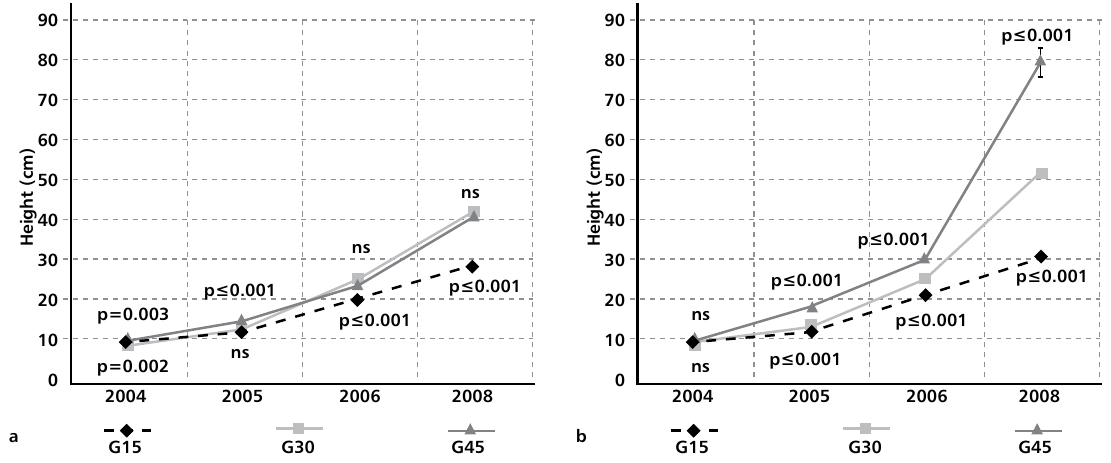
Figure 2 Height of sessile oak (a) and hornbeam (b) seedlings before (2004) and after cutting gaps of various sizes. Medium-size gaps were compared to the largest and to the smallest ones. Significance levels are given at the markers of the latter gaps. Standard errors are shown by whiskers. Where they are not indicated, standard errors were smaller than the size of the markers. Observation numbers are included in Table 2. The legend is shown on Figure 2a. ns – not significant; other abbreviations are explained at Table 1.